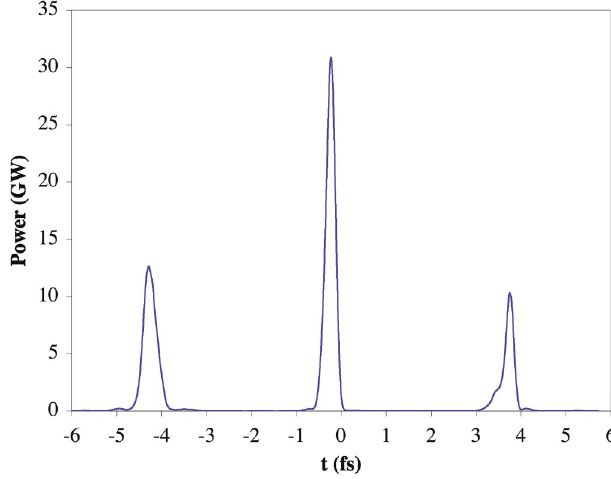
FIG. 6. (Color) An example of the x-ray power profile produced when using a single modulating laser, after 50 m.